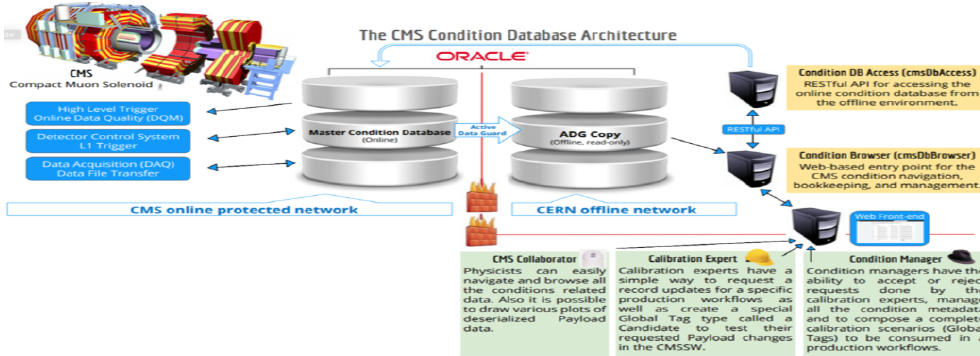
Figure 1. The CMS Condition Browser Service